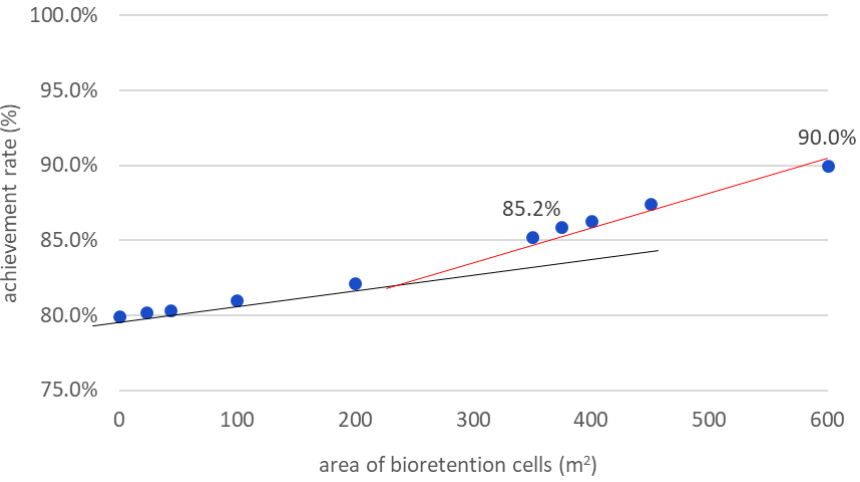
Figure 8. The relationship between the area of bioretention cells and the water quality achievement rate in the Jinggualiao